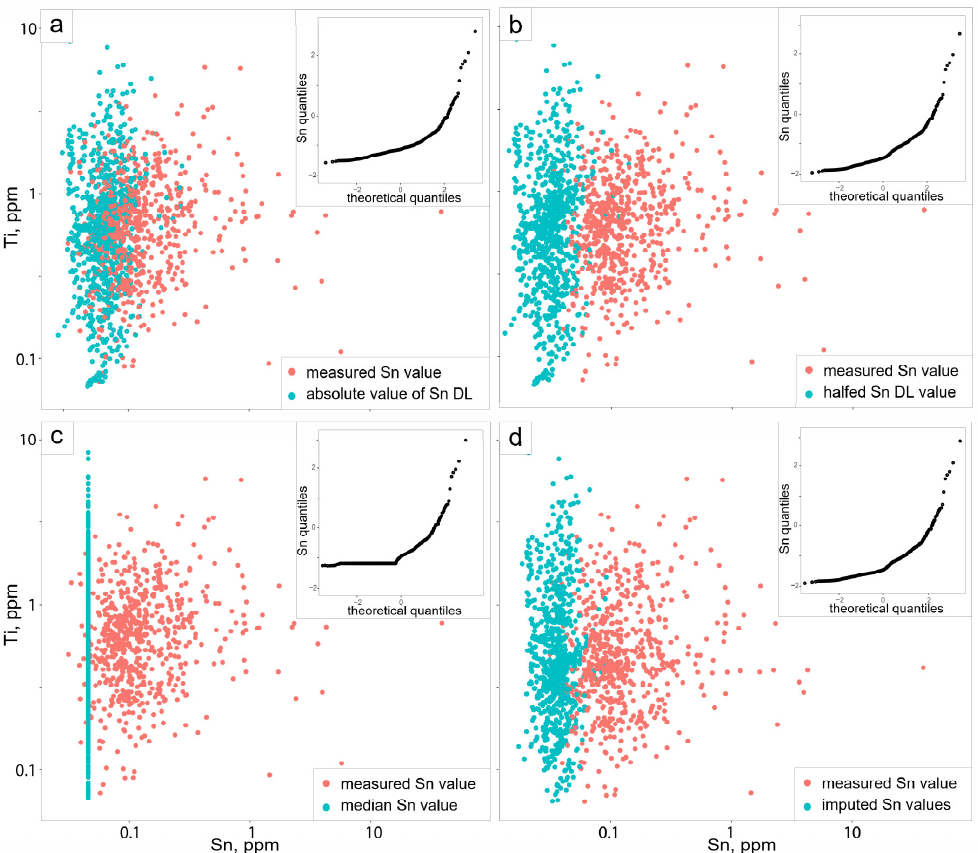
Figure 2. Quantile–quantile plots of Sn and bivariate plots of log-transformed Sn versus Ti in ppm from the N = 1501 dataset illustrating the effect of ( a ) taking absolute values of the detection limit, ( b ) division of a detection limit value by two, ( c ) fixed value imputation, e.g., median (calculated from the imputed dataset) and ( d ) multiplicative lognormal replacement. Note the similarity between b and d and the narrower range of imputed Sn values for d. Note that fixed value imputation results in asymmetric Sn distribution.